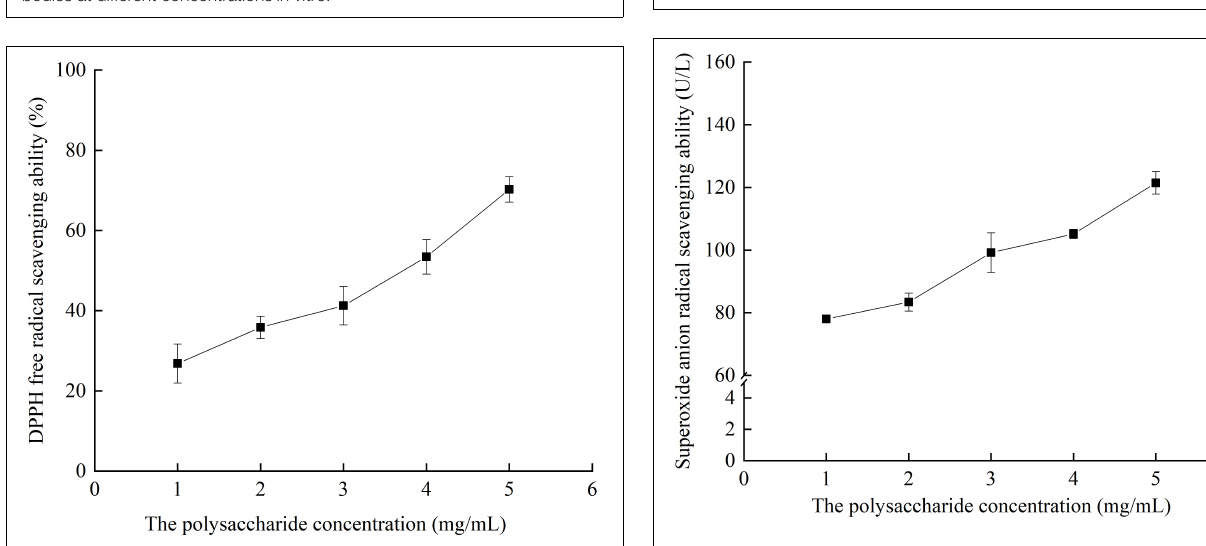
FIGURE 8 | DPPH radical scavenging ability of crude polysaccharides from fruiting bodies with different concentrations in vitro.